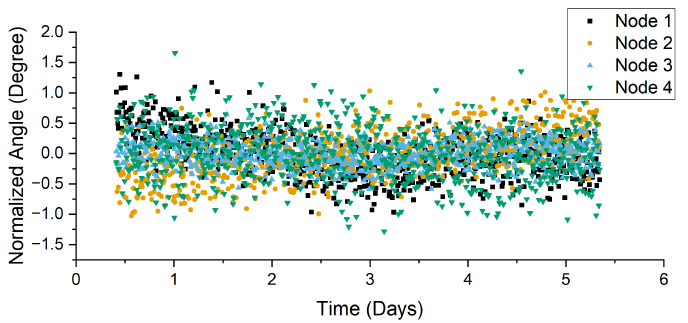
Figure 9. Normalized angle data over 5 days for 4 stationary nodes, demonstrating their stability and noise characteristics in a deployment